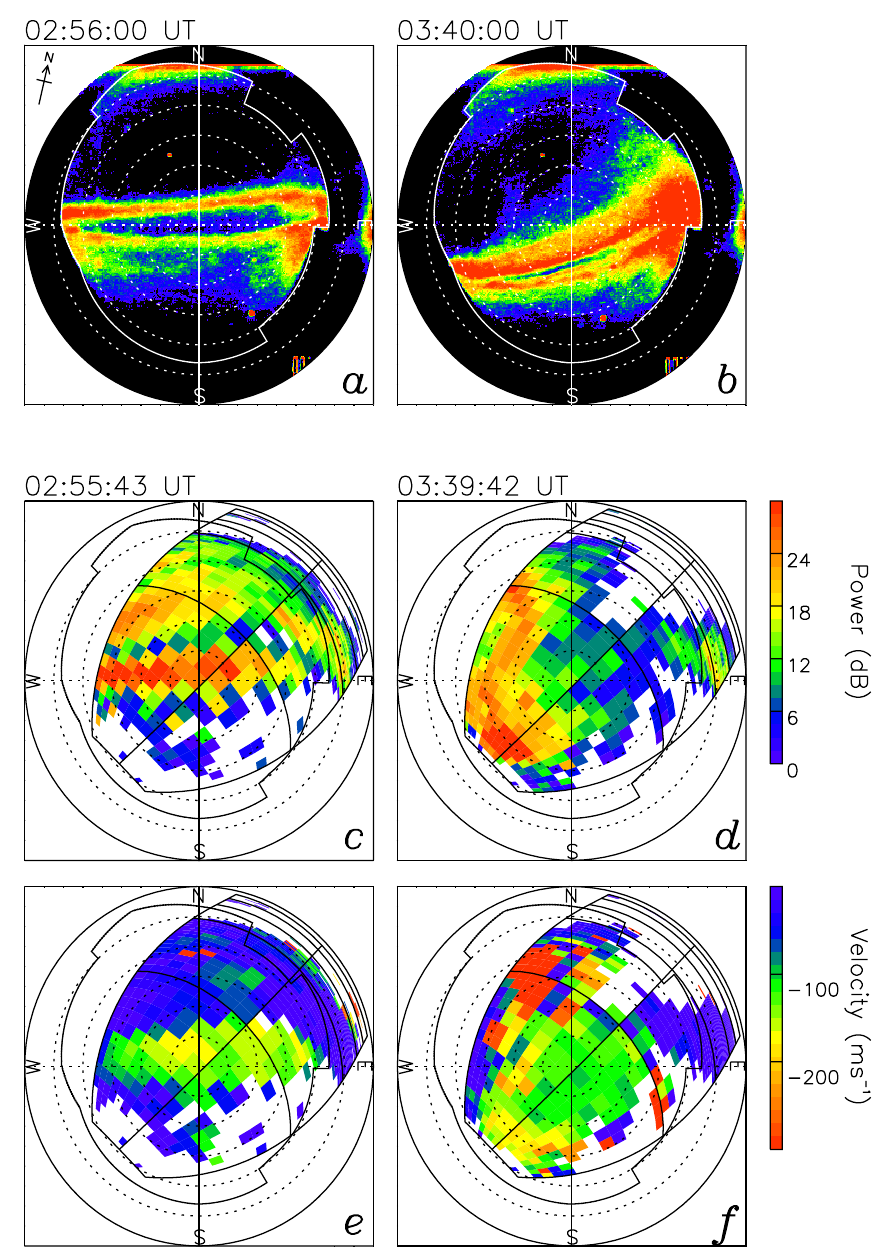
Fig. 2. Two all-sky images taken at (a) 02:56UT and (b) 03:40UT on 23 September 2000. Note that panel (a) corresponds to the time of the radar observations in Fig. 1. The circles mark the locii of zenith angle in steps of 15 ◦ . The irregular solid line marks the horizon due to buildings, etc. The vertical solid line shows the geomagnetic meridian passing through zenith, which is employed to produce keograms. The direction of geographic north is indicated in the top left